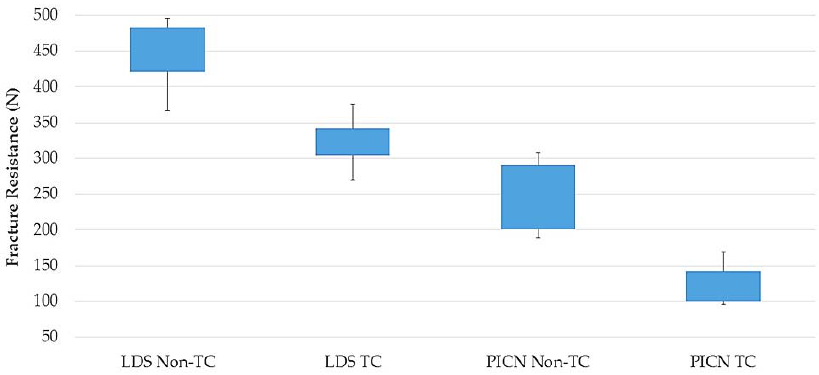
Figure 4. Box plot of microshear bond strength for each group.